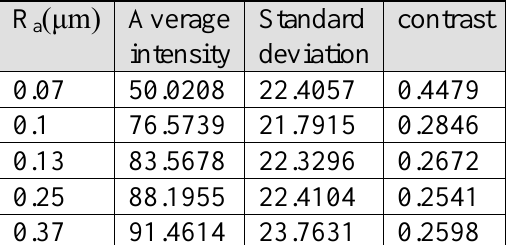
Table 1: Contrast values corresponding surface roughness values at incident angle 30 with non-specular direction .